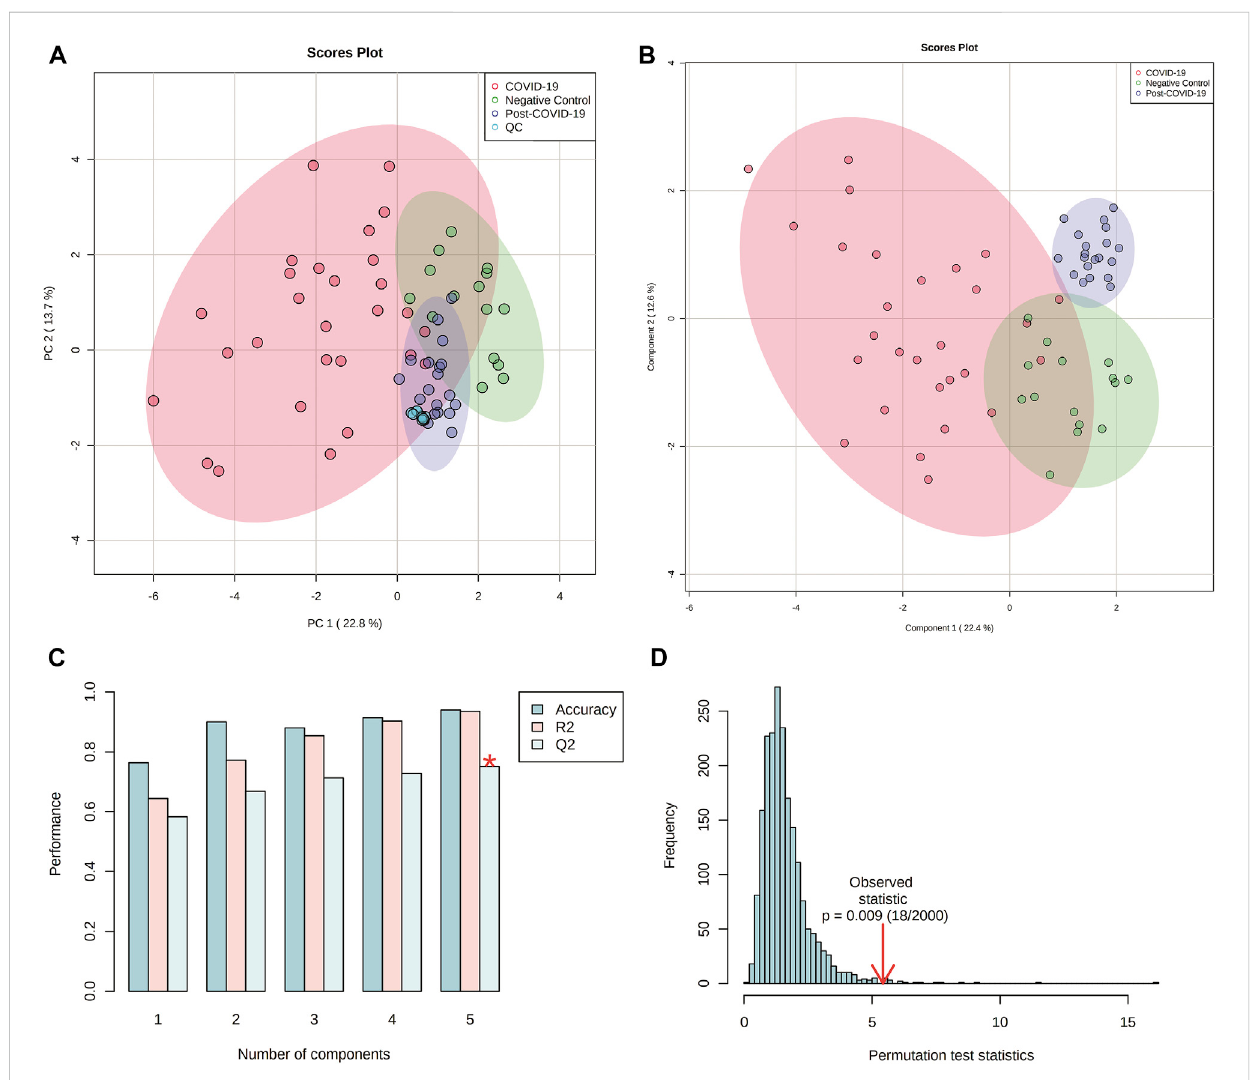
FIGURE 5 Multivariate analyses from plasma lipidomics pro fi le of negative controls, COVID-19 patients, and post-COVID-19 patients. (A) Score scatter plot based on PCA models including quality controls (QCs) samples (C) . (B) Score scatter plot based on PLS-DA models. (C) Cross validation (10-foldCV). (D) permutation test (2000 permutations). Figures were produced in Metabo Analyst software v 5.0